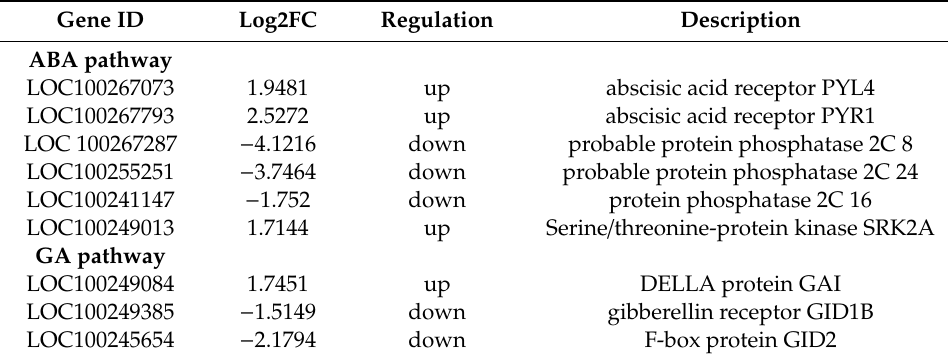
Table 1. DEGs related to hormone signaling pathway in treated and control bud samples.